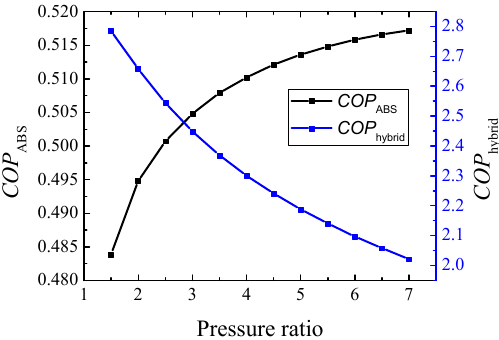
Figure 12. Effect of pressure ratio on sub-cycle and coupling COP.